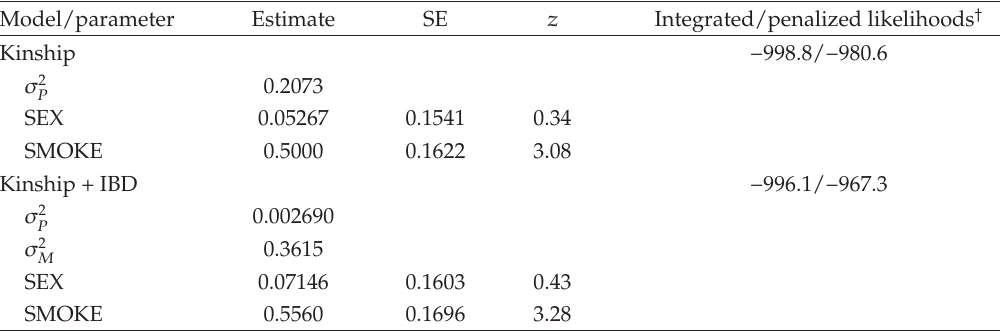
Table 4: AFFECTED and VEGFC under a Cox